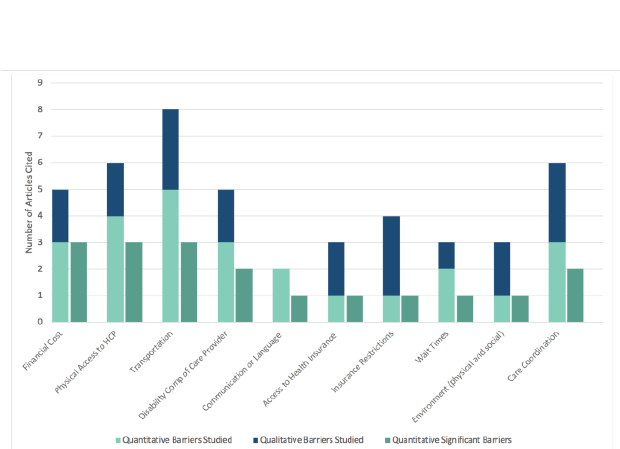
Figure 2 . Commonly cited barriers preventing access to healthcare evaluated in current literature 3,5-8,10-12,15,20-21